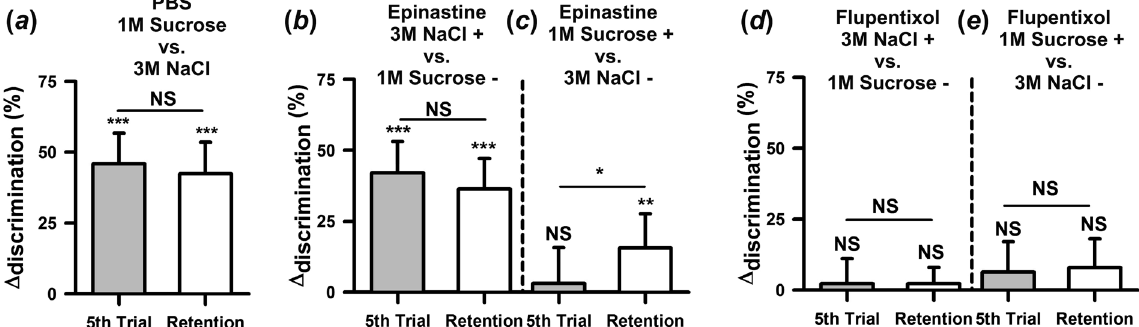
Figure 5. Aminergic pathways underlying gustatory SER conditioning. ( a ) Antennal discrimination learning of 1 M sucrose vs. 3 M NaCl in control bees. PBS-injected bees ( n = 85) learned the discrimination and remembered it 1 h later. ( b ) Blockade of octopaminergic signaling for 3 M NaCl ( + ) vs. 1 M sucrose ( − ). Δ disc values of epinastine-injected bees ( n = 88) show that the discrimination was learned and retained, thus showing no effect of octopaminergic blockade. ( c ) Blockade of octopaminergic signaling for 1 M sucrose ( + ) vs. 3 M NaCl ( − ). Δ disc values of epinastine-injected bees ( n = 64) show that in this case the discrimination was not learned; retention, although significant, reached only 15%. ( d ) Blockade of dopaminergic signaling for 3 M NaCl ( + ) vs. 1 M sucrose ( − ). Flupentixol-injected bees ( n = 86) did not learn the discrimination and therefore did not exhibit significant retention. ( e ) Blockade of dopaminergic signaling for 1 M sucrose ( + ) vs. 3 M NaCl ( − ). Flupentixol-injected bees ( n = 64) did neither learn nor memorize the gustatory discrimination. NS: non- significant; * P < 0.05; ** P < 0.01, *** P < 0.0001. Error bars on Δ disc levels represent 95% confidence